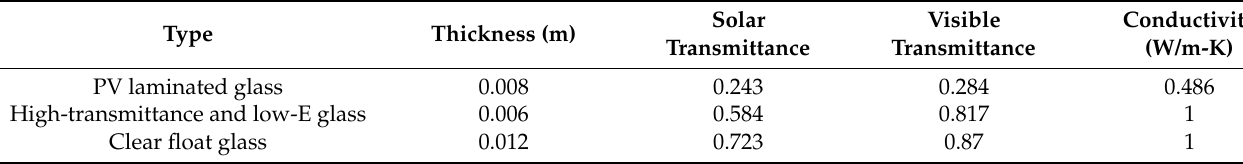
Table 3. Properties of layers of the STPV